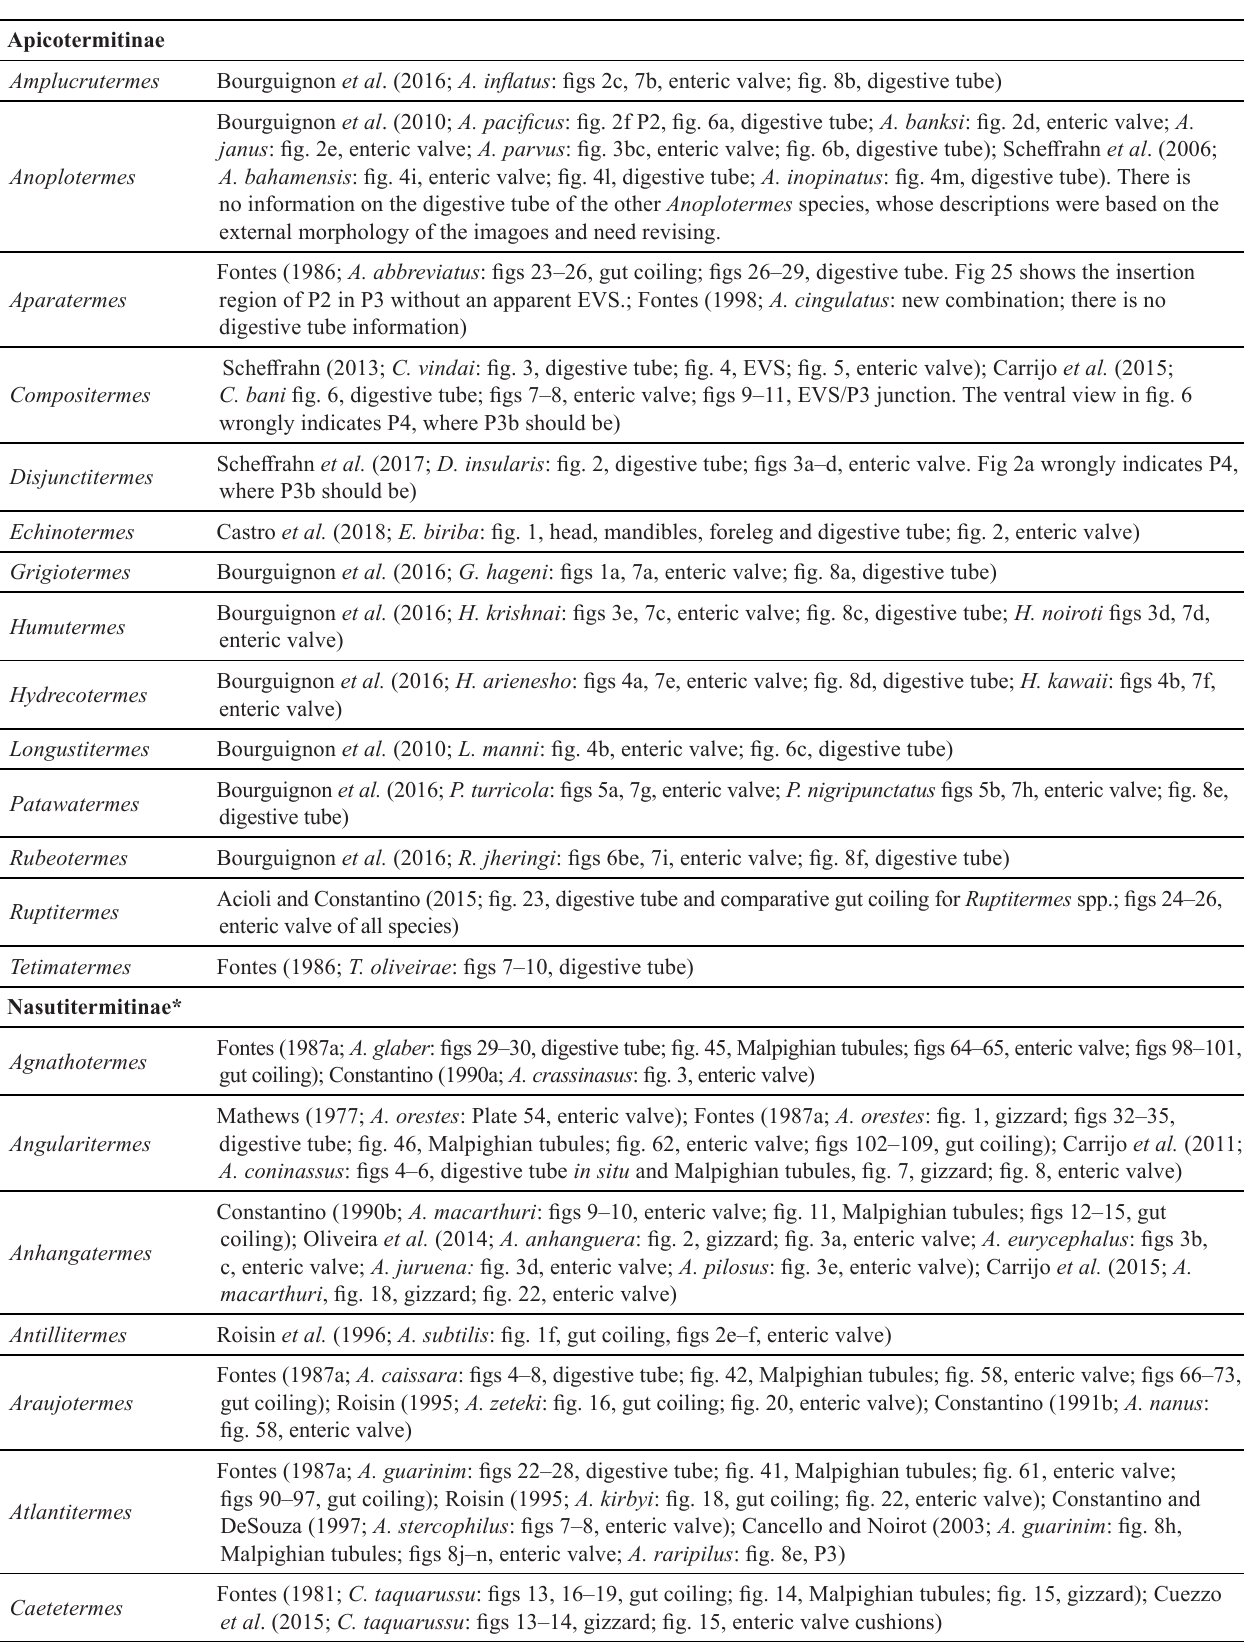
Table 1. List of taxonomic studies that treat the worker caste of Neotropical Termitidae